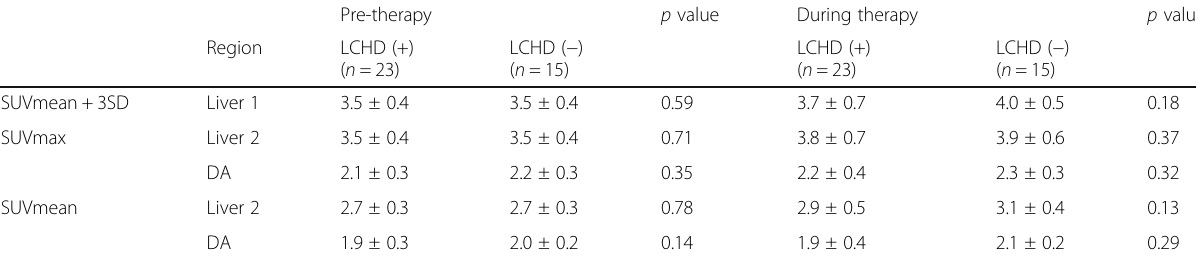
Table 6 The effect of low-carbohydrate diet for the thresholds Pre-therapy p value During therapy p